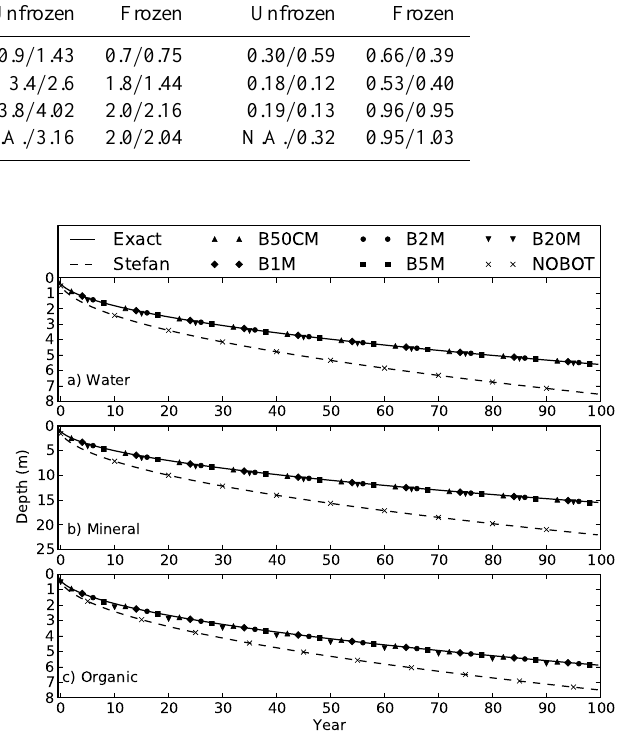
Figure 3. Comparisons of outputs from DOS-TEM simulations, ex- act Neumann solutions (Exact), and Stefan’s equation (Stefan) for (a) water, (b) mineral soil, and (c) organic soil over a 100-year pe- riod. The term B50CM means simulations from the DOS-TEM with bottom-up forcing at 50cm beneath the lowest freezing or thaw- ing front, and likewise for other similar terms. NOBOT means no bottom-up forcing. The outputs from the DOS-TEM have been plot- ted for the middle of every 10th year and different cases have been started from different years in order to make the figures more read-